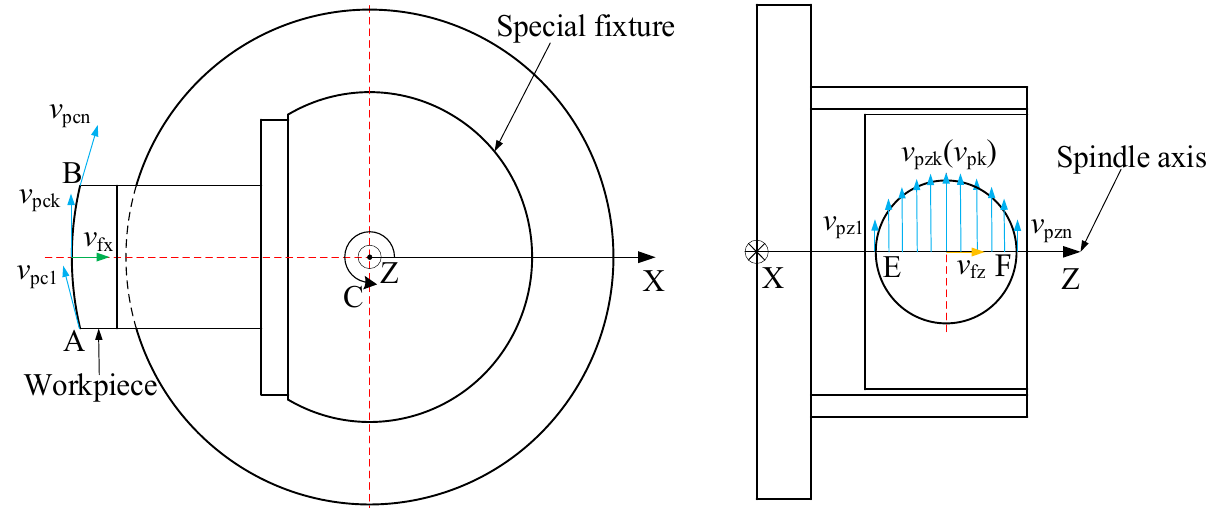
Figure 8. Schematic diagram of peripheral cutting speed distribution along the Z-axis diameter on the workpiece.